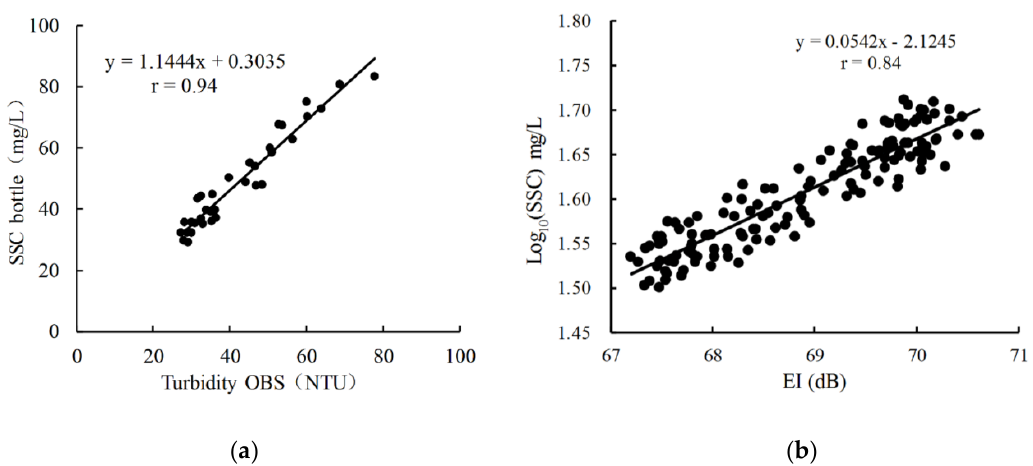
Figure 3. ( a ) Calibration between the turbidity (NTU) and SSC (mg/L) of bottle samples; ( b ) conversion of EI (dB) to high-frequency SSC (mg/L).